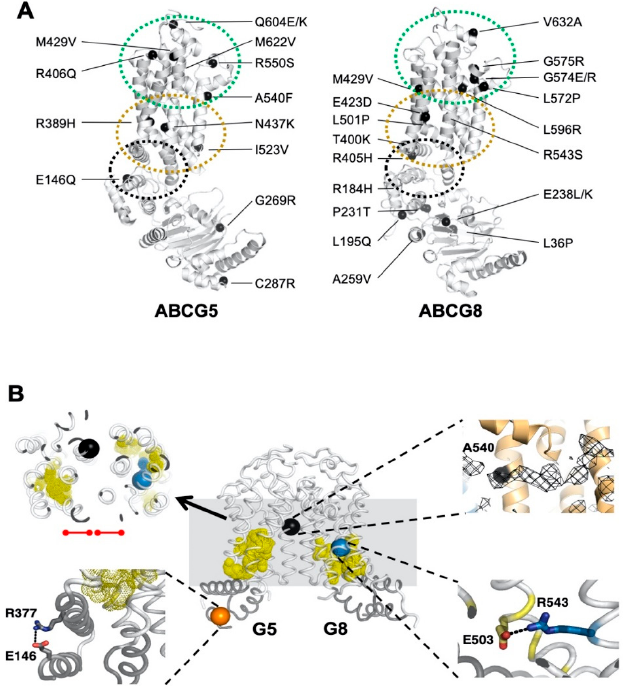
Figure 1. Disease-causing mutations and single-nucleotide polymorphisms (SNPs) in ATP-binding cassette (ABC) sterol transporters (ABCG5 / G8). ( A ) Localization of ABCG5 / G8 residues carrying missense mutations. The positions of disorder-related polymorphisms or mutations are highlighted in black spheres on the structures of ABCG5 (Protein Data Bank (PDB) identifier (ID): 5D07, chain C) and ABCG8 (PDB ID 5D07, chain D). Structural motifs are indicated in dashed ovals: triple-helical bundle (black), transmembrane domain (TMD) polar relay (yellow), and extracellular domain with re-entry helices (green). ( B ) Microenvironment of G5-E146, G5-A540, and G8-R543. ( Middle ) The transmembrane domains (white) and the triple-helical bundle (gray) are plotted in tube-styled cartoon presentation, showing the α -carbons (spheres) of G5-E146 (orange), G8-R543 (blue), and G5-A540 (black). The polar relays are plotted in dotted yellow spheres. ( Top left ) Slapped top view shows G5-A540 situated more than 10 Å away from the polar relay of either subunit (red dot-ended lines). ( Top right ) Near G5-A540 shows a cholesterol-shaped electron density (mesh) in the crystal structure of ABCG5 / G8. The Fo − Fc di ff erence electron density map was contoured at 3.0 σ . ( Bottom left ) At the triple helical bundle of ABCG5, E146 interacts with R377 through their side-chain termini in a distance of hydrogen bonding, 3.5 Å (black dashed line). ( Bottom right ) In the ABCG8 polar relay, R543 interacts E503 through their side-chain termini in a distance of hydrogen bonding, 3.1 Å (black dashed